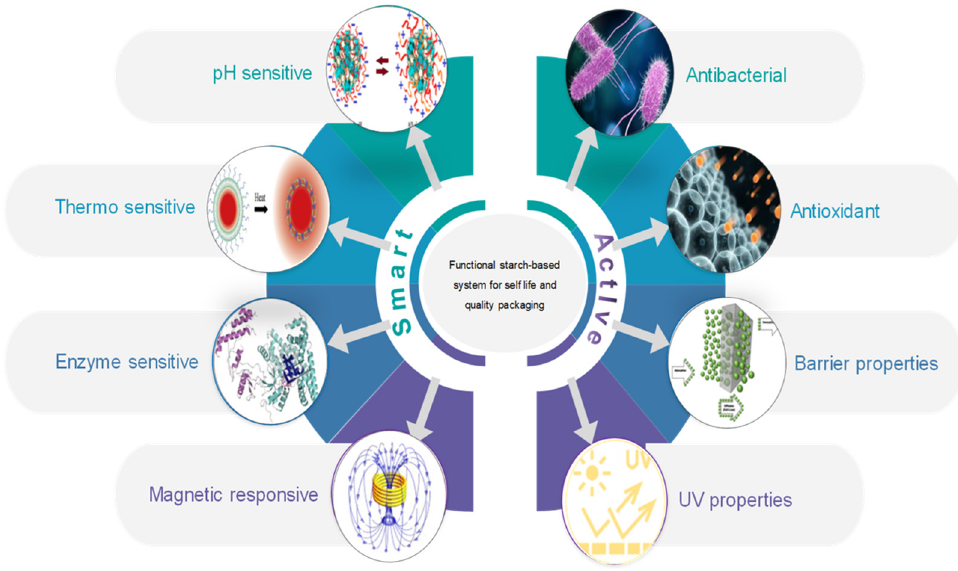
Figure 3. Active and smart starch-based food packaging to improve shelf life.